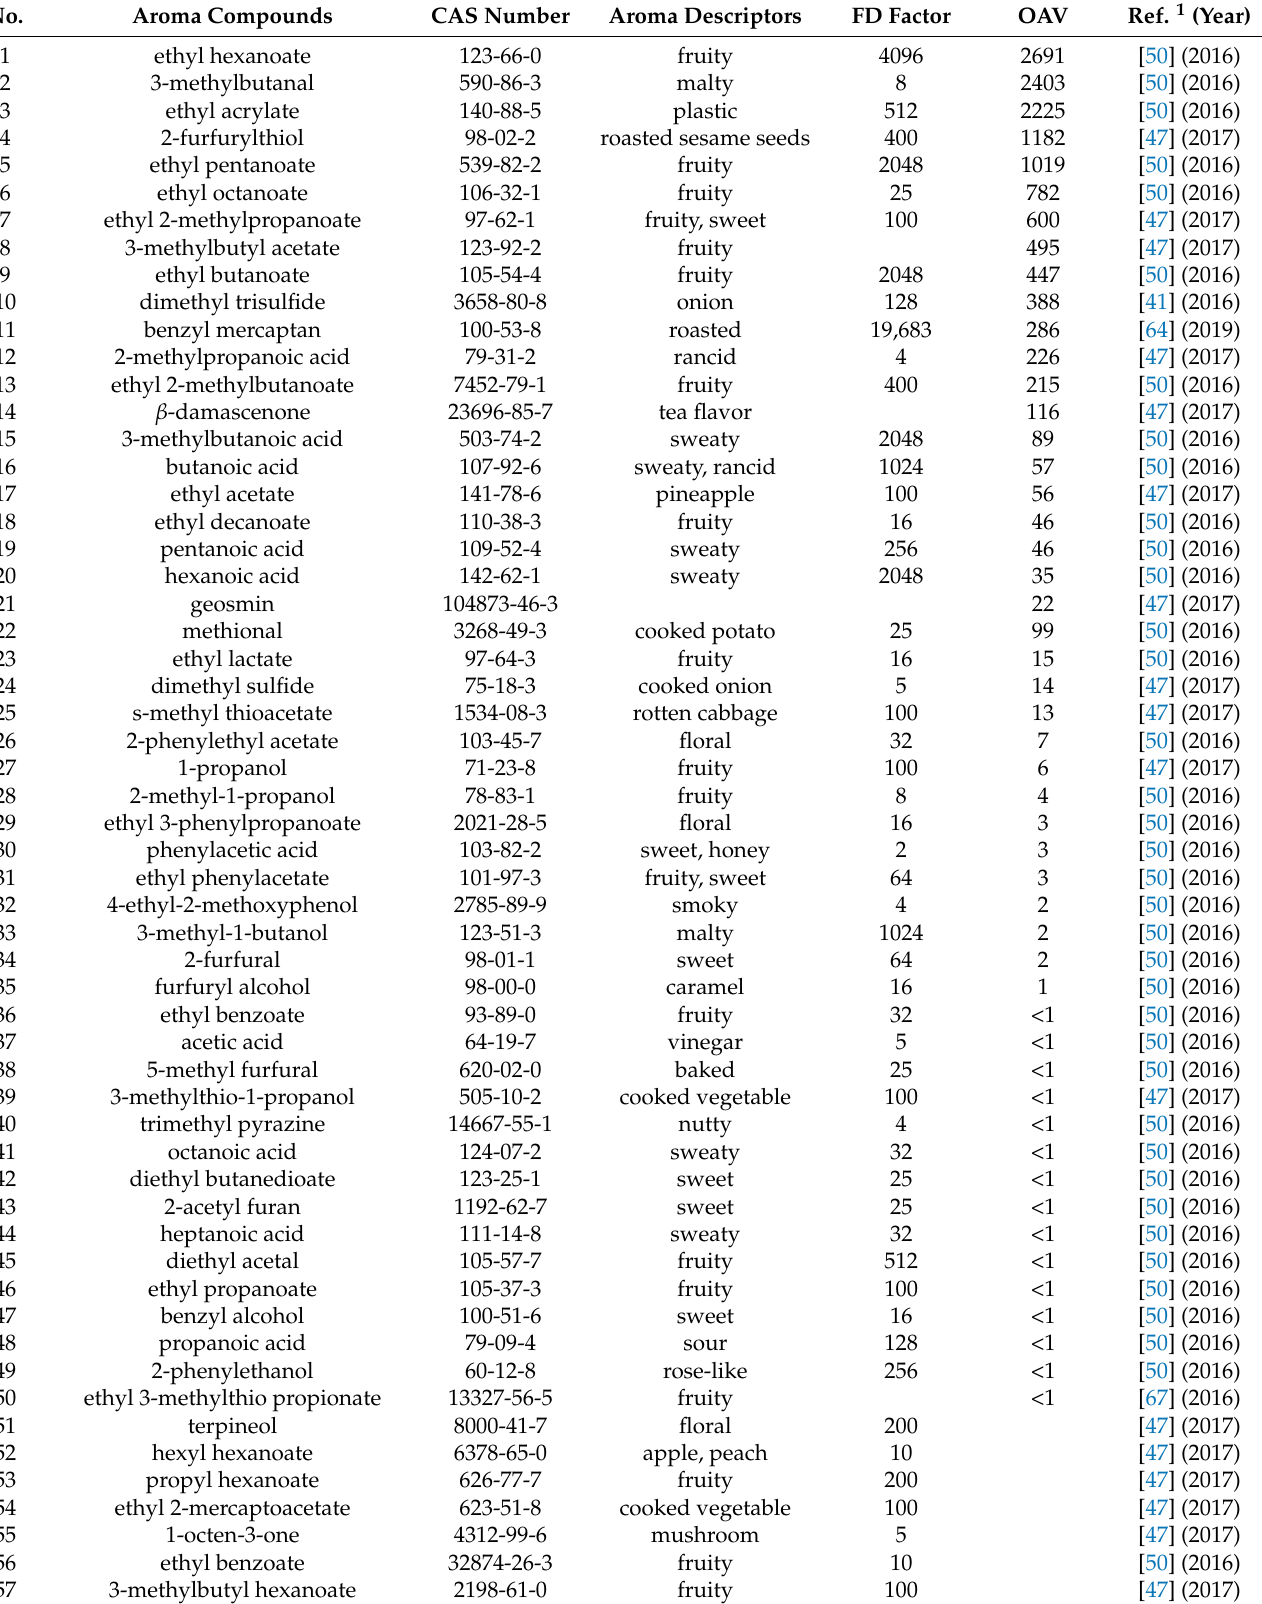
Table 1. The important aroma components for sesame flavor